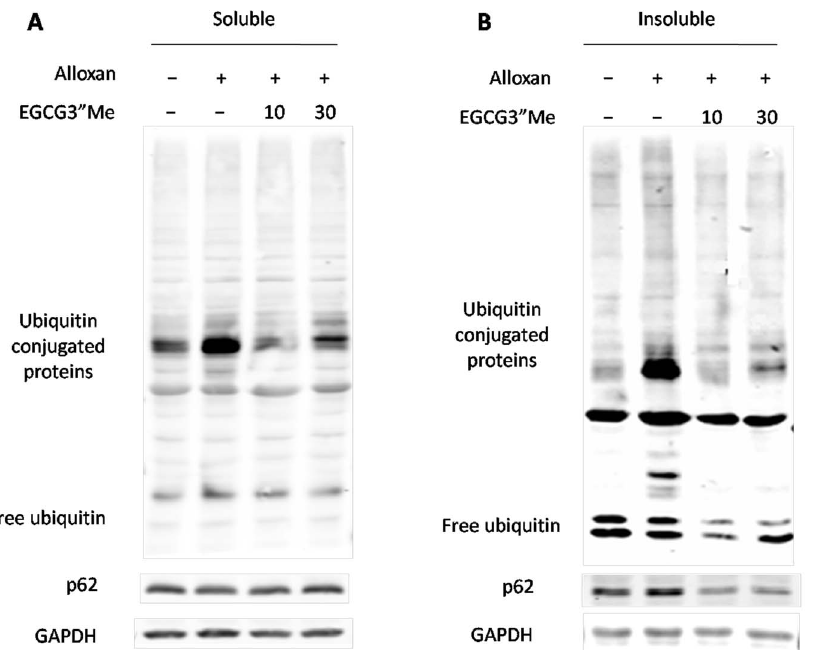
Figure 5. Immunoblot analysis of ubiquitin-conjugated proteins and p62 from the kidneys of diabetic mice. Ubiquitin-conjugated proteins profiles and p62 proteins can be used as a screening or diagnostic tool to characterize protein aggregates occurring in complex tissues and cells. (A) the levels of p62, free ubiquitin, ubiquitin-conjugated proteins with high molecular weights were not altered significantly for any treatment group. (B) p62 and insoluble ubiquitin modification proteins were highly expressed in the SDS fraction (insoluble proteins) in diabetic kidneys;